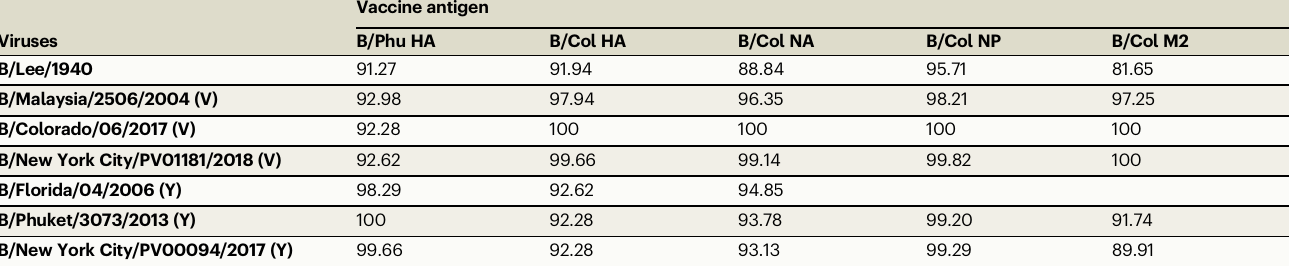
Table 1 | Amino acid similarity (%) between vaccine antigens and challenge strains